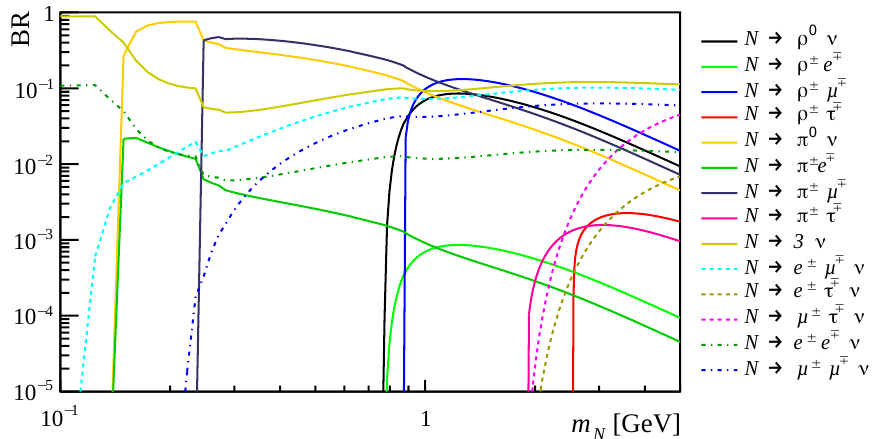
Figure 6. HNL branching fractions used in this work as a function of the HNL mass for scenario